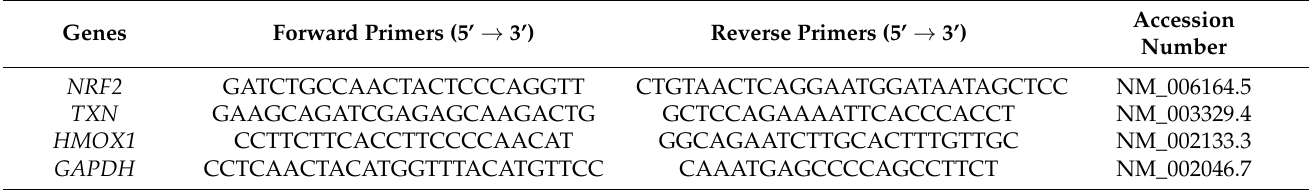
Table 1. Primer sequences for antioxidant signaling